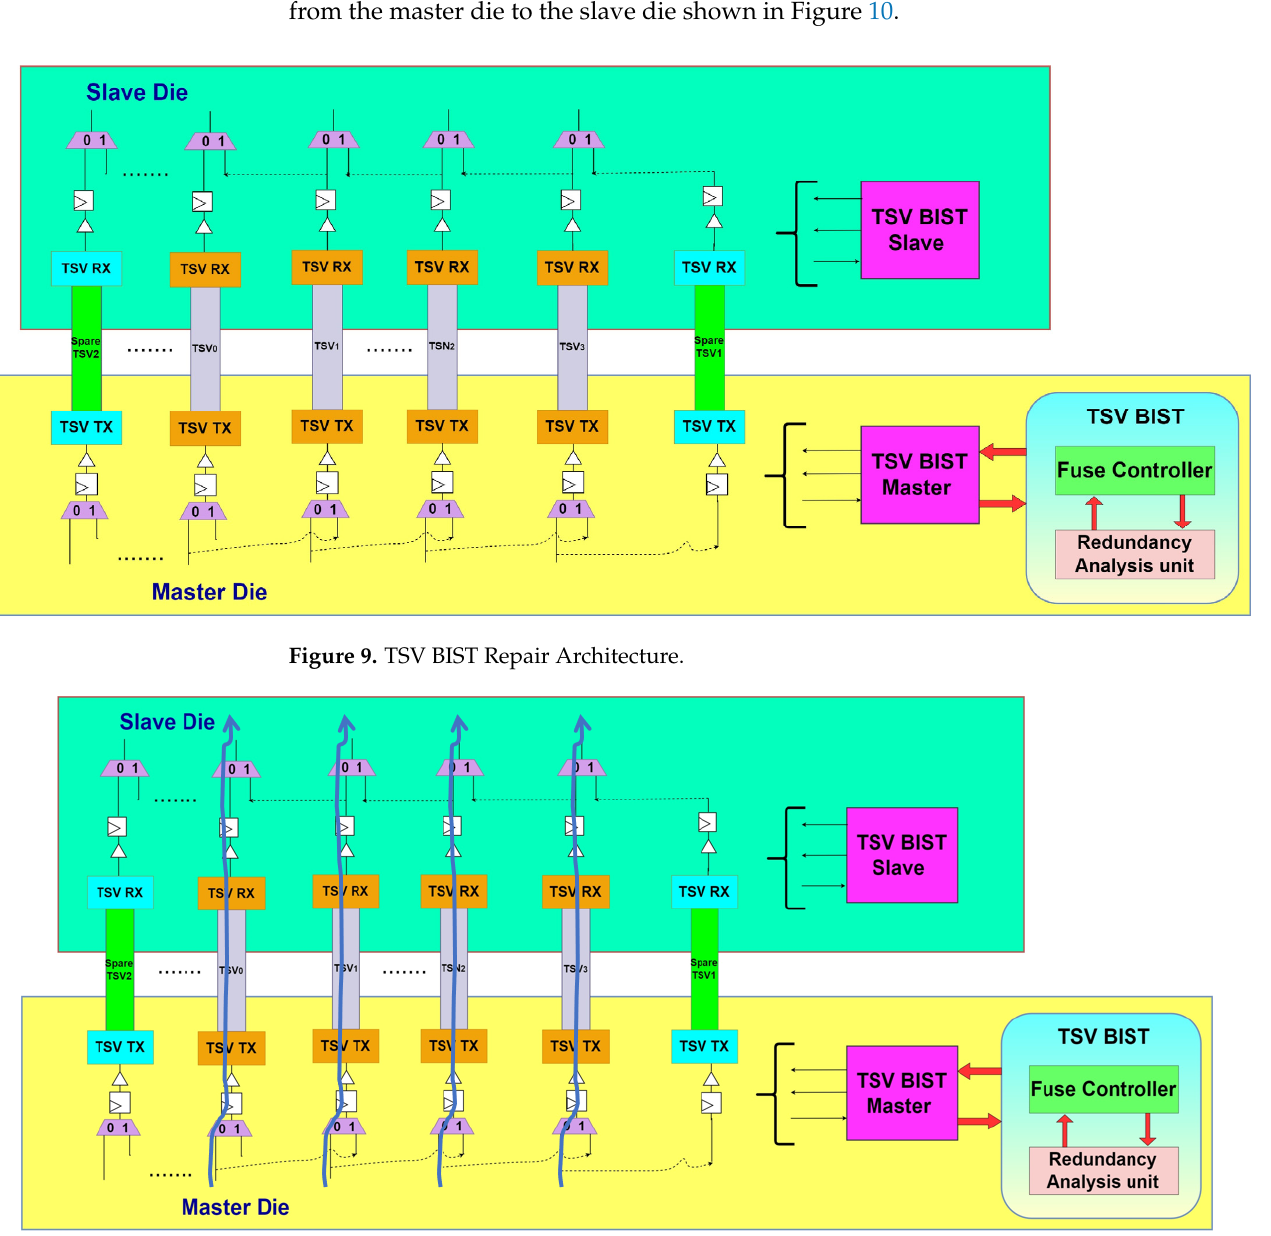
Figure 10. TSV BIST Repair flow in case of no fault in the TSV group.